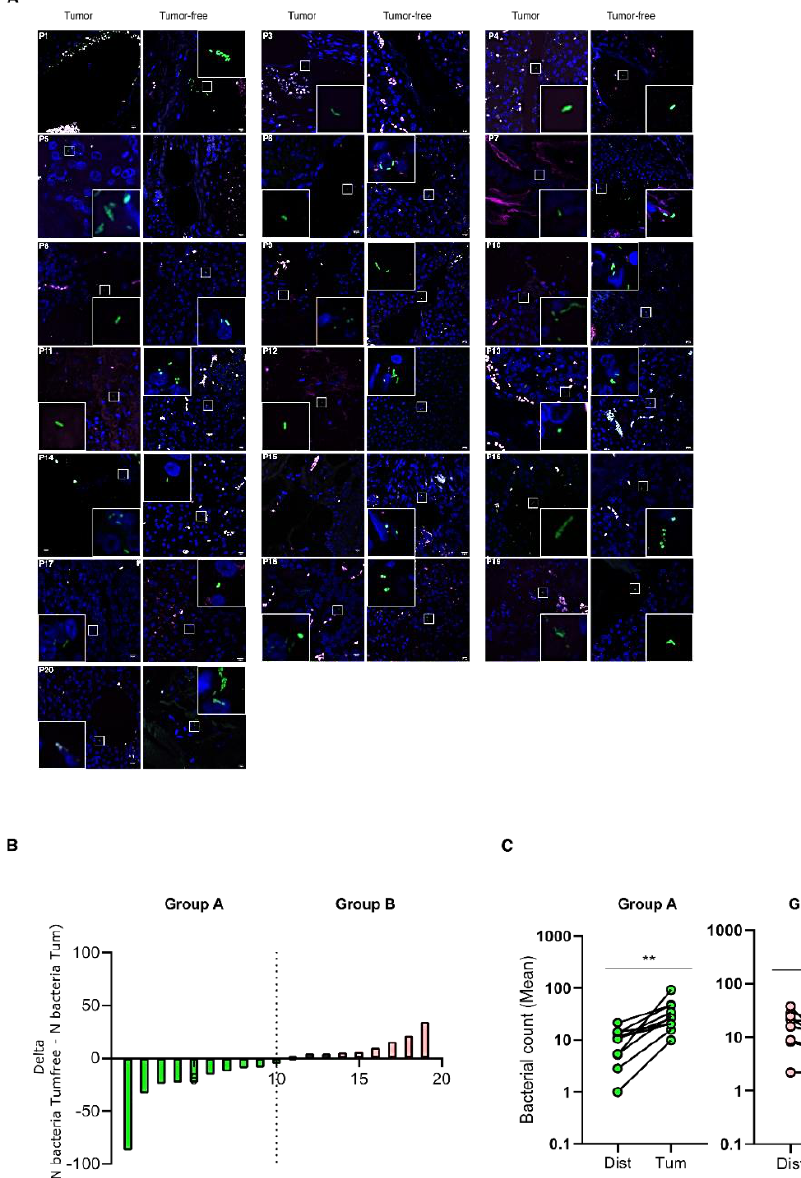
Figure 3. Comparison between bacterial infiltration in paired tumoral and tumor-free pan-NEN tissue. ( A ) Representative confocal microscopy images of the bacterial signal observed within paired tumoral and tumor-free pan-NEN patients (N = 18). Scale bar = 10 µ m. ( B ) Bar plot representing the difference between bacteria abundance within paired tumoral and tumor-free tissue (N bacteria Tumfree-N bacteriaTum) (N = 19). ( C ) Comparison between the mean of bacterial count within paired tumoral and tumor-free tissue of Group A and B. Wilcoxon test was used to assess statistical significance. ** p -value < 0.05.